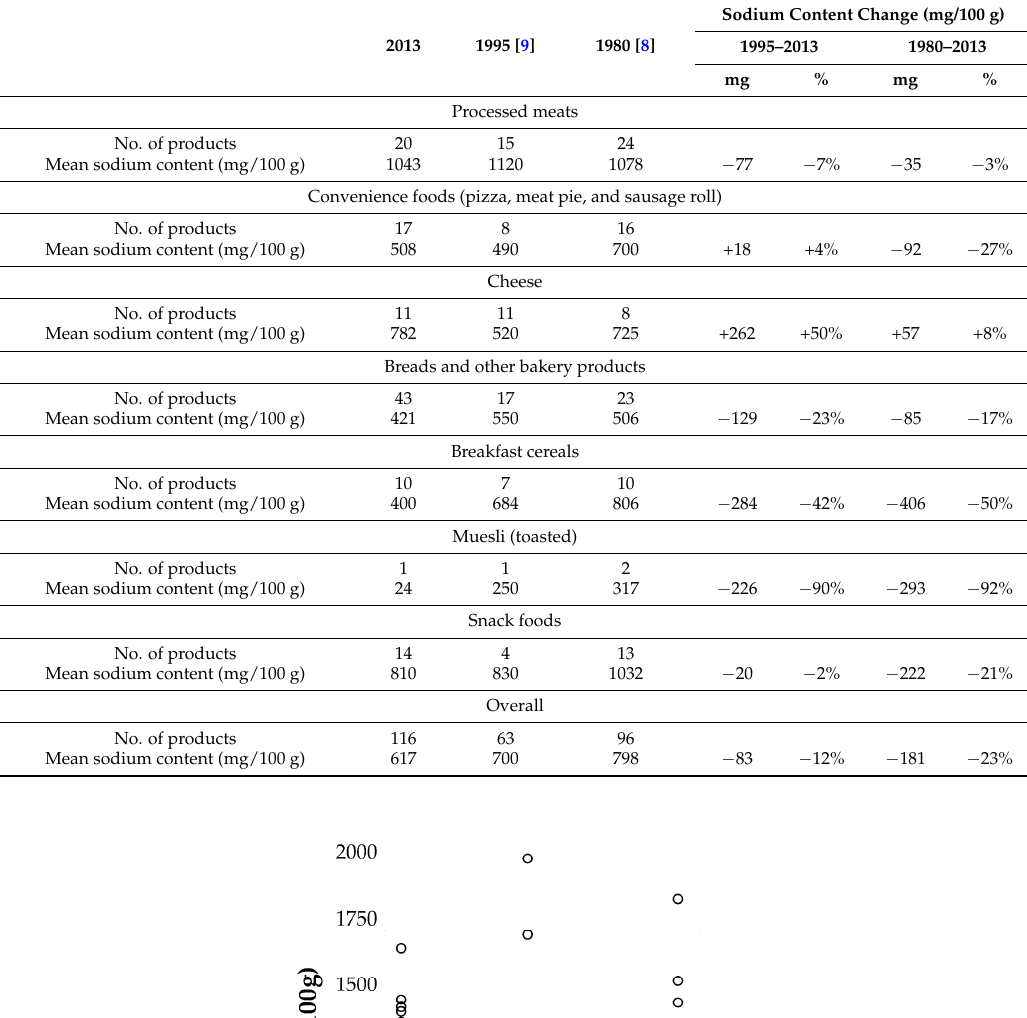
Table 2 Changes in sodium content of Australian processed foods between 1980 and 2013. Table 2. Changes in sodium content of Australian processed foods between 1980 and 2013.